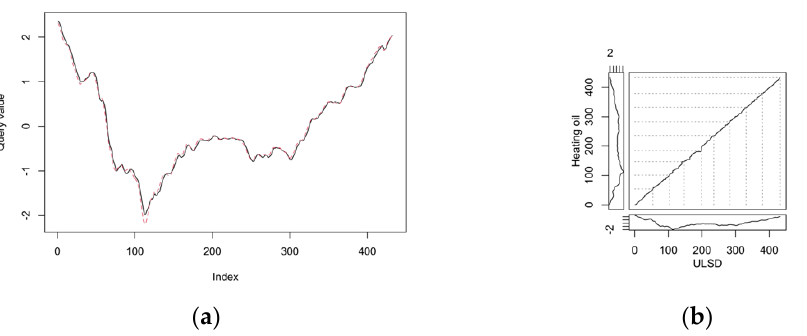
Figure 5. Alignment plots for ULSD and heating oil for the full period. ( a ) Two-way, ( b ) Three-way. On the two-way plot the black solid line for ULSD, the red dashed line for heating oil. Source: own elaboration on the basis of data from www.stooq.com (accessed on 19 April 2021).